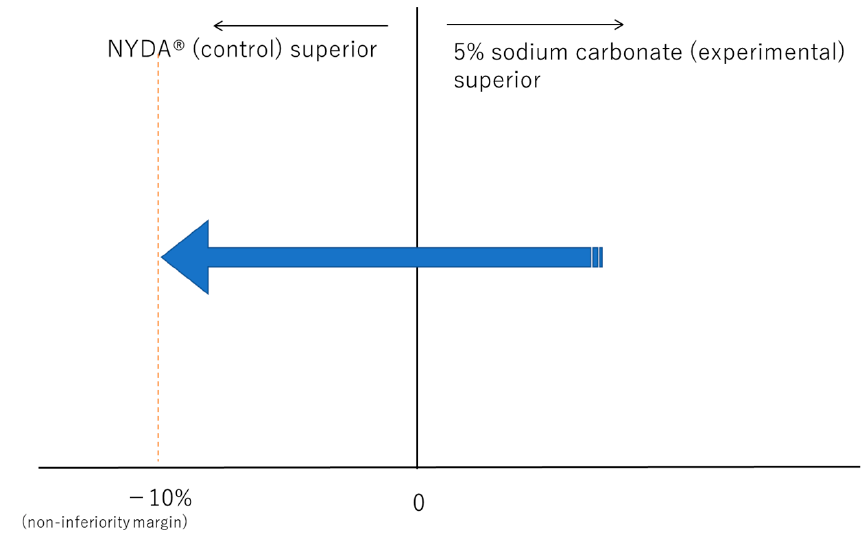
Figure 1. Non-inferiority margin and the relationship with 95% confidence interval.